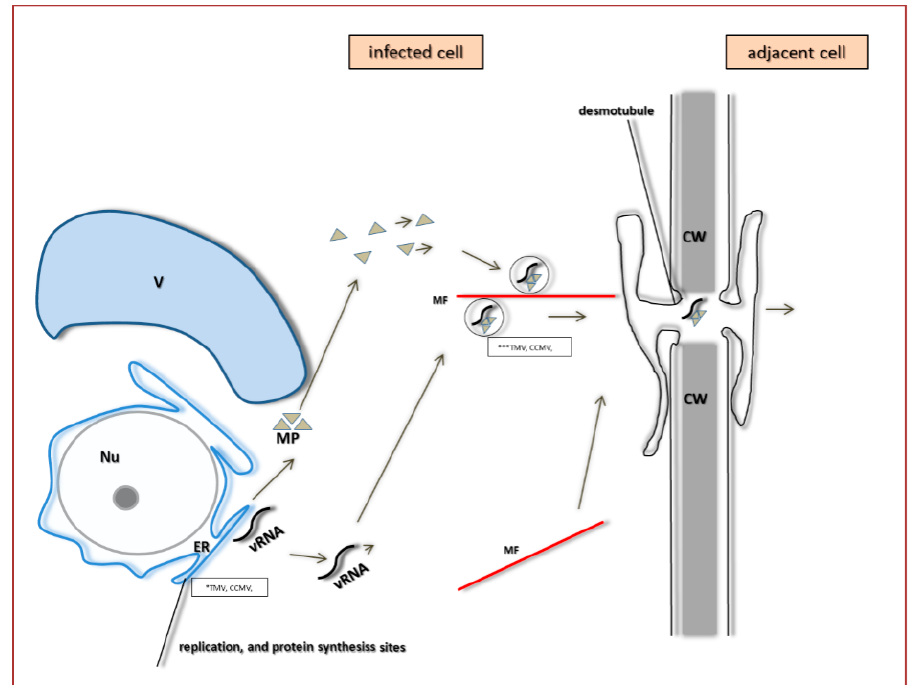
Figure 9. Model of the pathogen life cycle, from replication to cell-to-cell transport, by compiling both TMV and CCMV as the examples of viral RNA (vRNA) replicated at the endoplasmic reticulum (ER), and then transported as a complex with movement protein (MP) along actin microfilaments (MF) to the plasmodesmata (PD) region. Simultaneously, MP is also transported alongside microtubules to PD. MP modifies the size exclusion limit (SEL) of PD. Frame with *TMV, CCMV replication sites of vRNA. Frame with ***TMV, CCMV complexes of vRNA and MP, transported with help of MF.